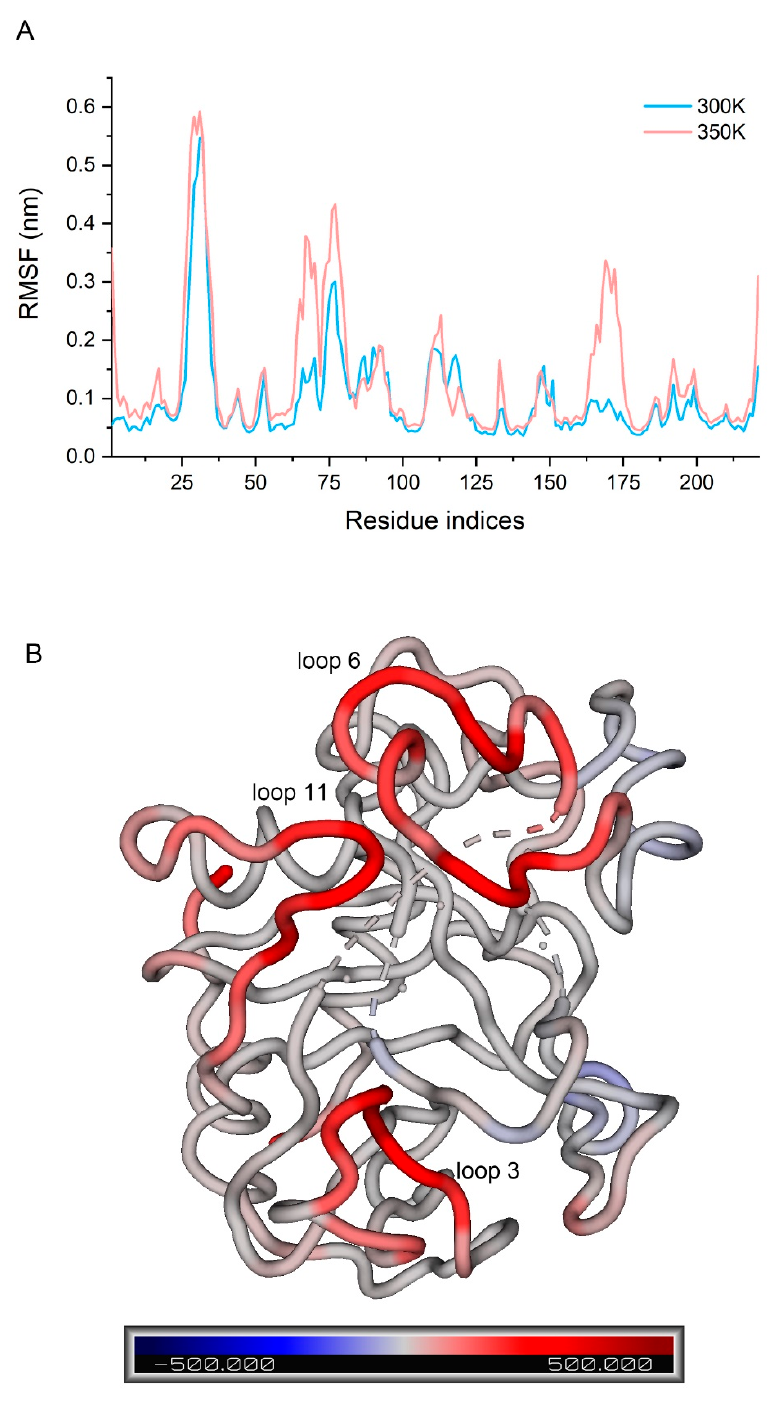
Figure 6. ( A ) RMSF of the concatenated trajectories at 300 K and 350 K; ( B ) di ff erence in B-factor between 300 K and 350 K in the structure by